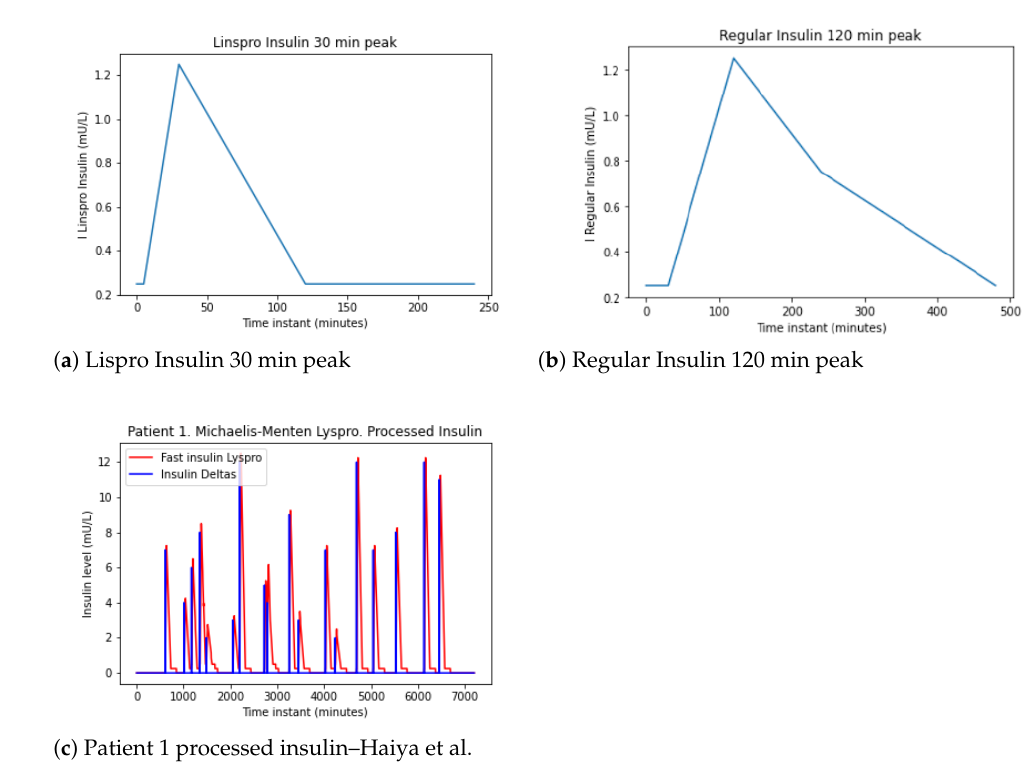
Figure 4. Patient 1 insulin data pre-processing—Haiya et al.